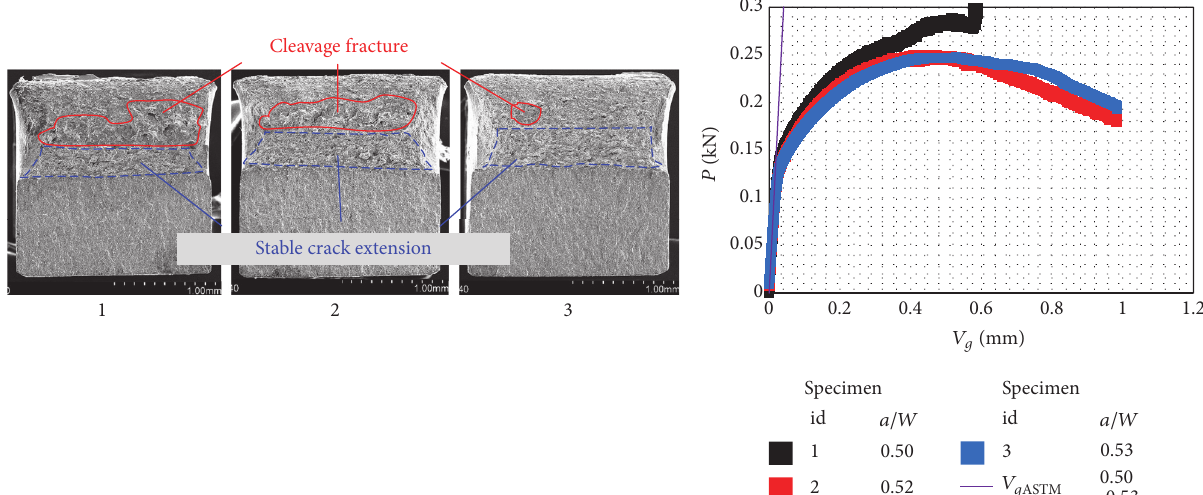
Figure 11: Fracture surfaces and load 𝑃 versus crack-mouth opening displacement 𝑉 𝑔 diagrams of the 2t SE(B) specimens (S55C, 20 ∘ C). Large stable crack extension before cleavage fracture was observed, as predicted from the (4𝛿 𝑡 , 𝜎 22𝑐 ) failure criterion. Note that 𝑉 𝑔 = 1 mm does not correspond to the final fracture.